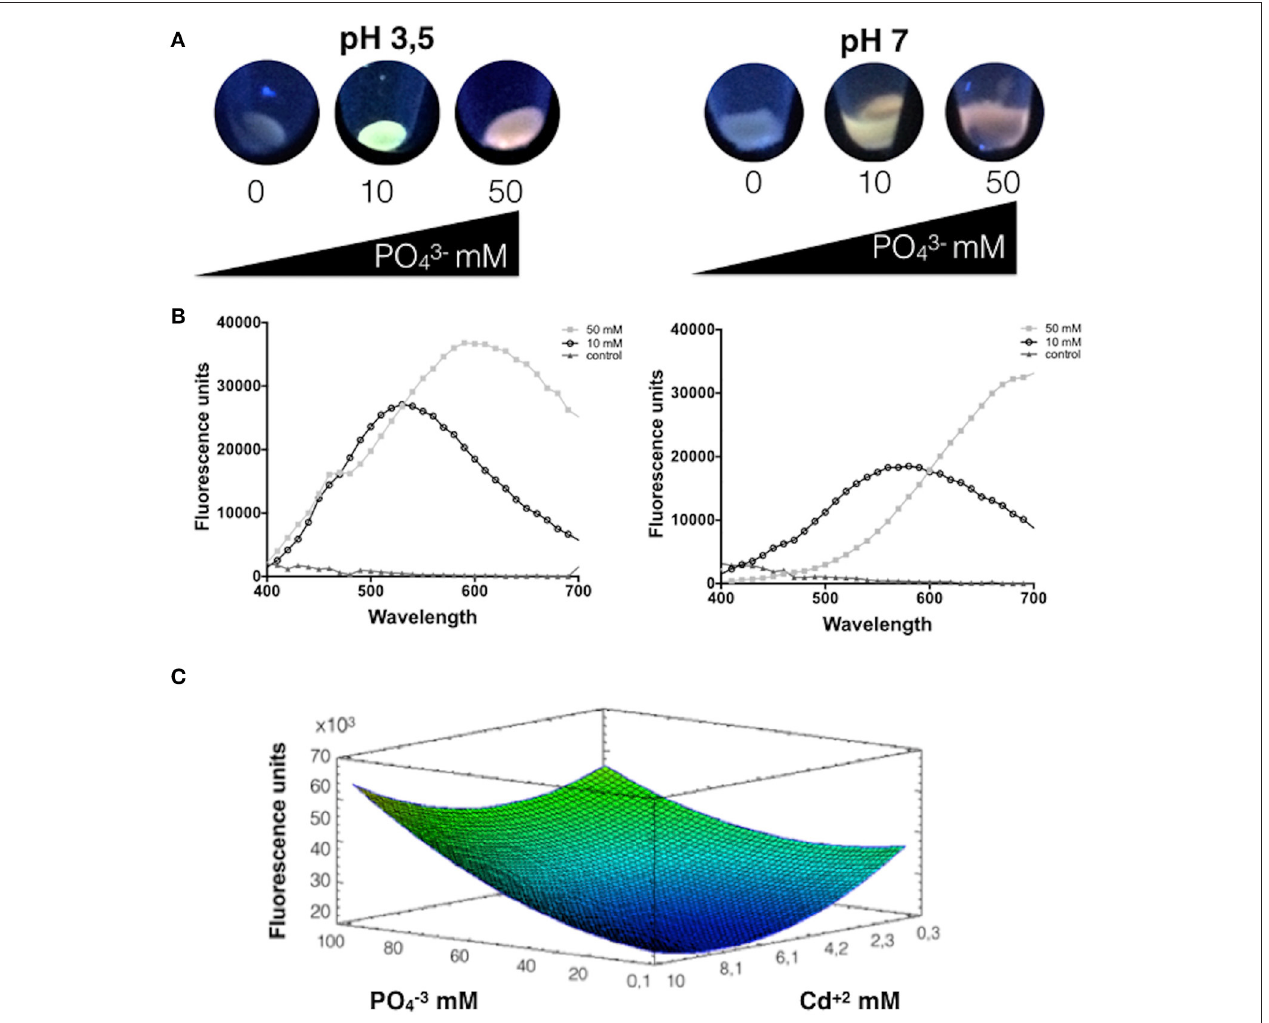
FIGURE 1 | Phosphate favors the biosynthesis of CdS-QDs at pH 3.5. (A) Fluorescence of cells exposed to CdS-QDs biosynthesis conditions during 24h in presence of different phosphate concentrations (Cd 2 + 0.66mM and phosphate 0, 10, or 50mM). Fluorescence was evaluated after exposure to UV light (360nm). (B) The emission spectra show the fluorescence peaks for each condition at pH 3.5 (left) and pH 7.0 (right). (C) Response surface for a two variables model for the effect of cadmium and phosphate on A. ferrooxidans QDs production in supernatants, determined as fluorescence emission ( R 2 : 72%; p < 0.05). Warm colors represent an increase in value for the variable under